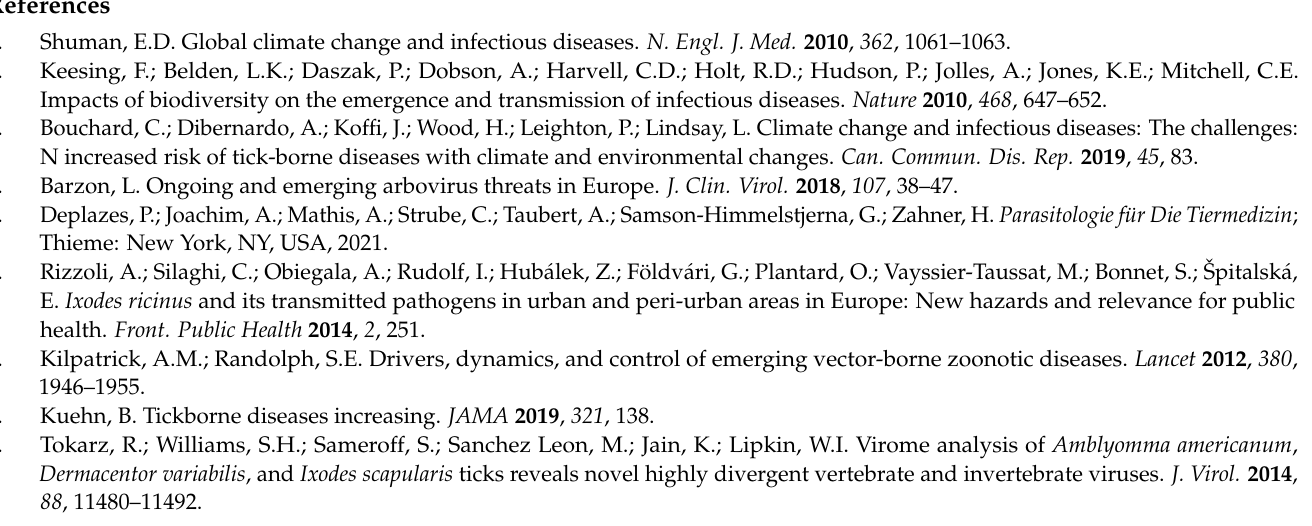
Table S3: Overview of tick saliva pools sampled from ticks found on wild animals and NS5 PCR results of serum samples from wild animals and tick samples; Table S4: Overview of flagged ticks from several locations with information regarding life stages and/or sex and amount of ticks per pool; Table S5: Overview of pools by location and by the sampled game animal with NS5 PCR results and number of ticks per pool; Table S6–S11: Overview of tested serum samples for ALSV VP2 by LIPS assay; Figure S1: Card of Lower Saxony with